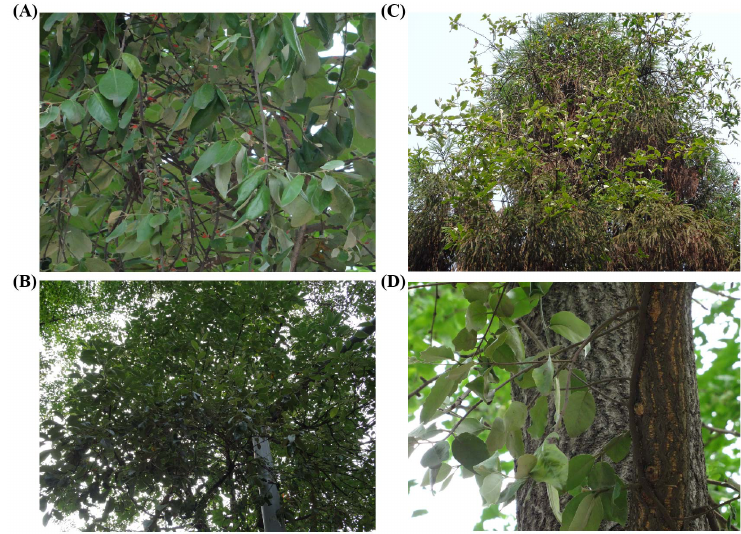
Figure 1. The host plants were ’parasited’ by T. nigrans . ( A ) Broussonetia papyrifera. ( B ) Cryptomeria fortunei. ( C ) Cinnamomum septentrionale. ( D ) Ginkgo